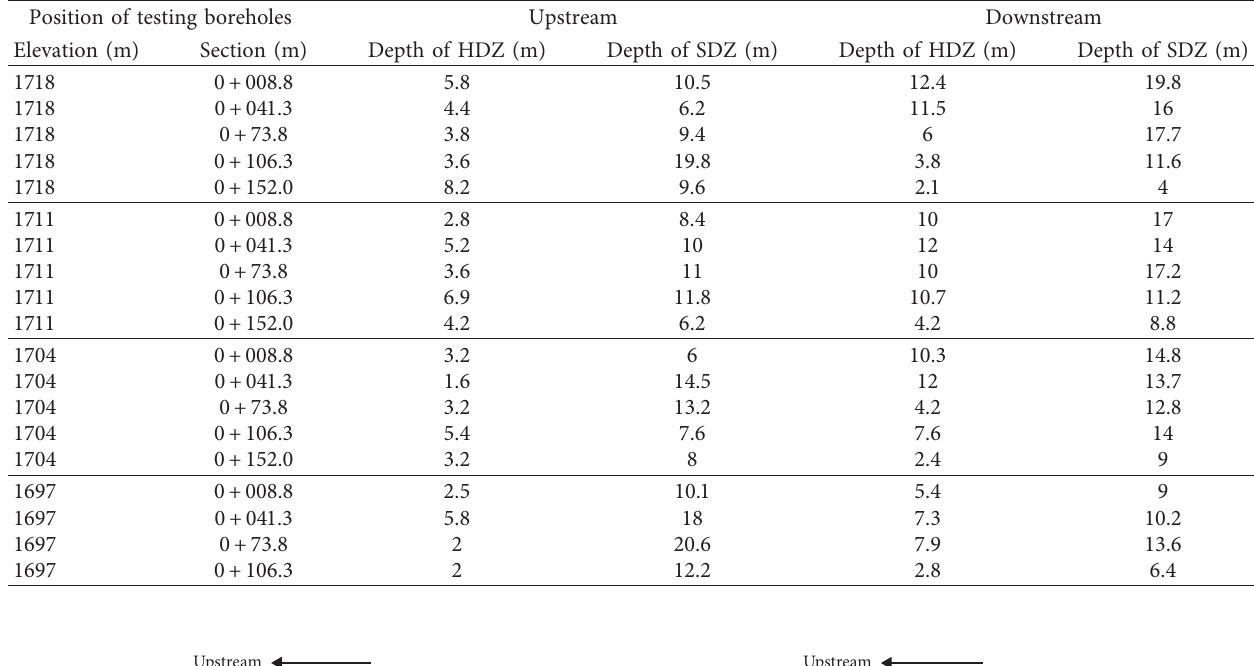
Table 2: Depth of EDZs around the main powerhouse in Houziyan project.